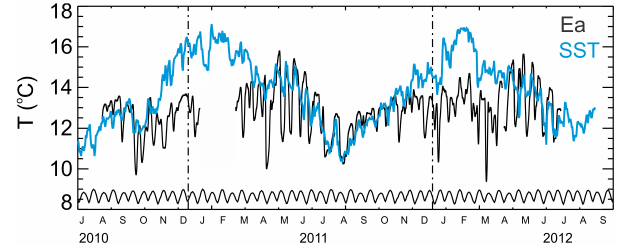
Figure 5. Temperatures from near-bed (Ea, Fig. 1) and satellite- derived sea surface temperature (SST). The arbitrarily scaled spring-neap envelope is along the base of the panel.